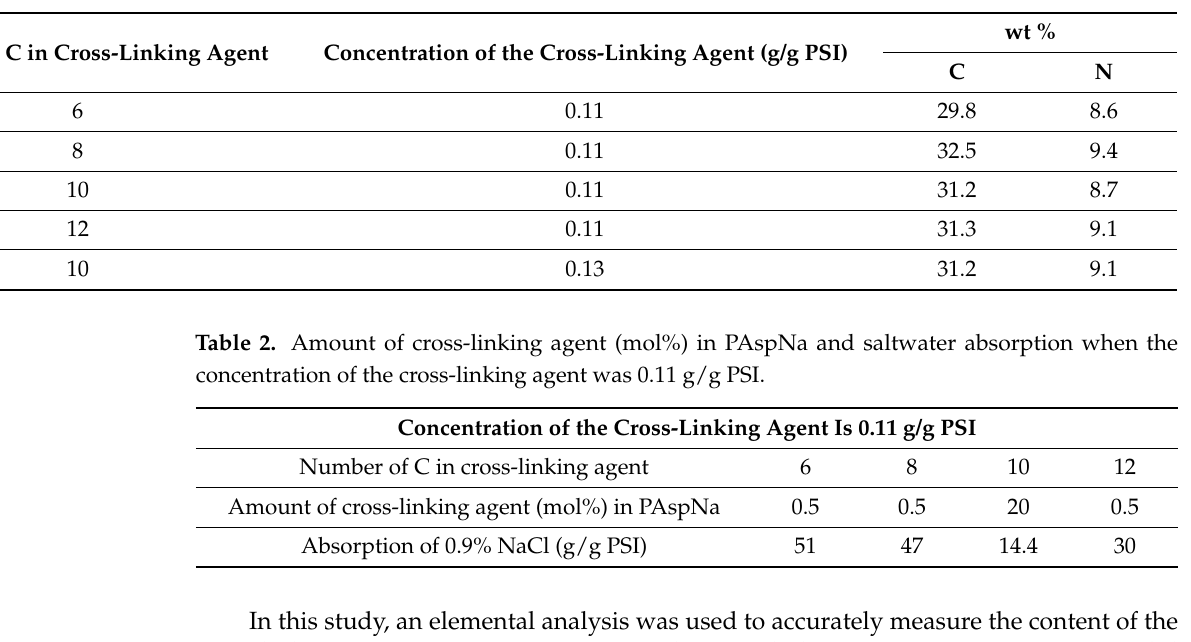
Table 1. C and N contents (wt %) in PAspNa.